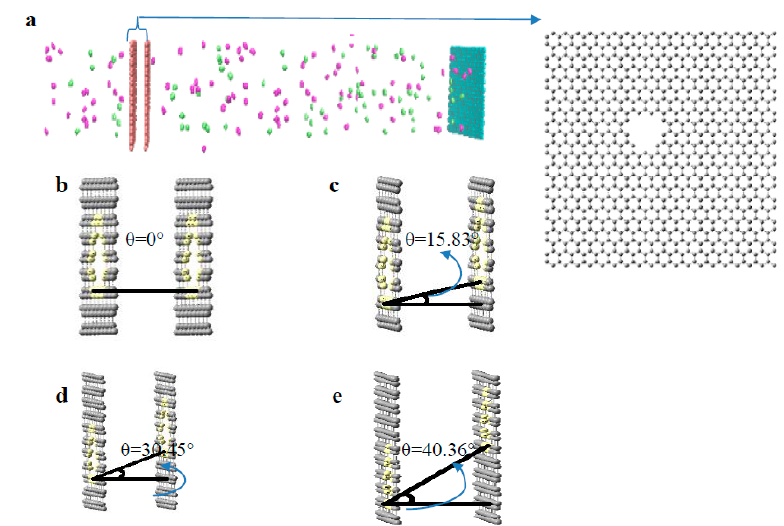
Figure 1. Molecular dynamic (MD) simulation classification and nano pores angle assemblies; ( a ) simulation organization and structure of each one of nanoporous graphene (NPG) layer with pore density 3%, ( b – e ) pores angles between two graphene layers.